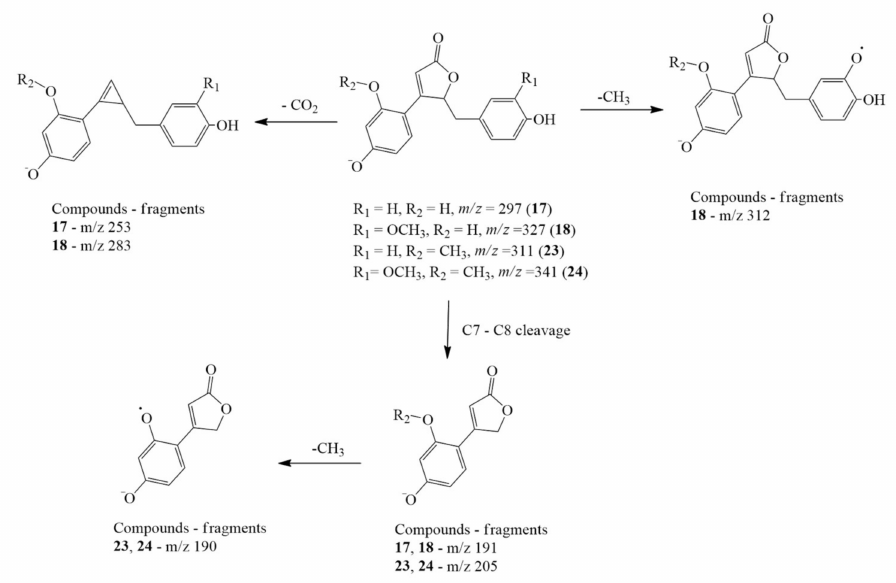
Figure 2. Proposed characteristic fragmentation pathway of compounds 17 , 18 , 23, and 24 (Clito- rienolactones D, C, B, and A,